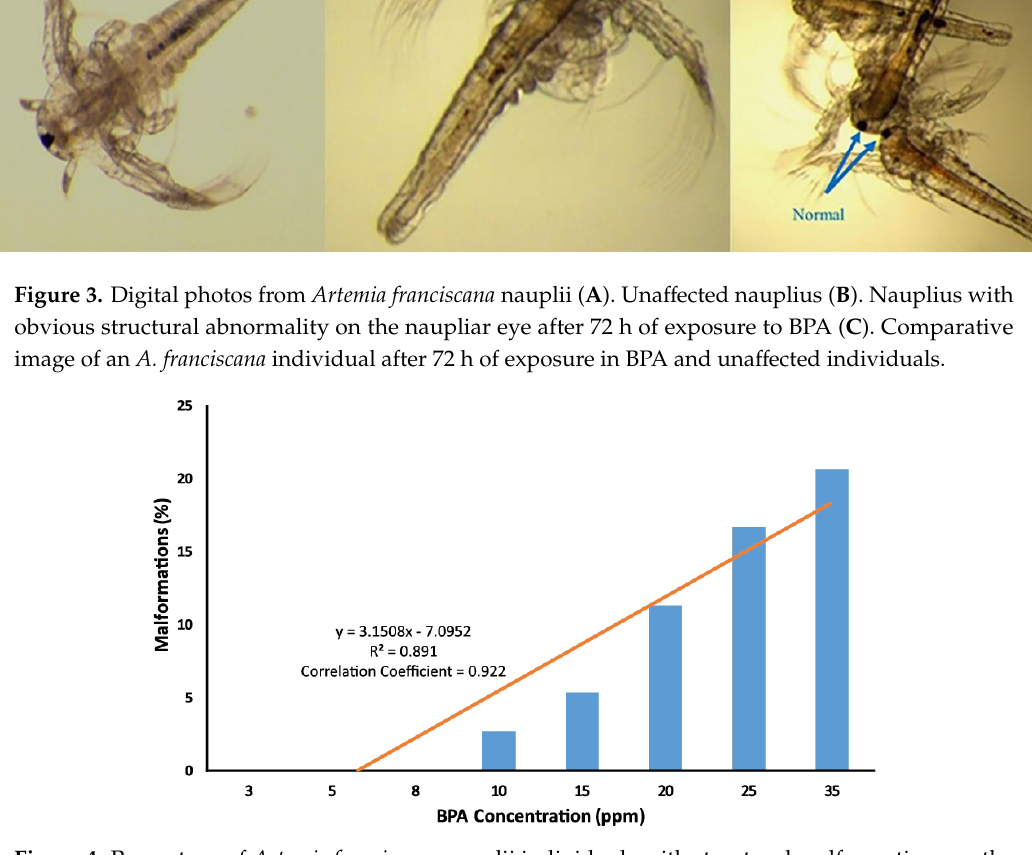
Figure 4. Percentage of Artemia franciscana nauplii individuals with structural malformations on the naupliar eye after 72 hours of exposure to different concentrations of BPA.